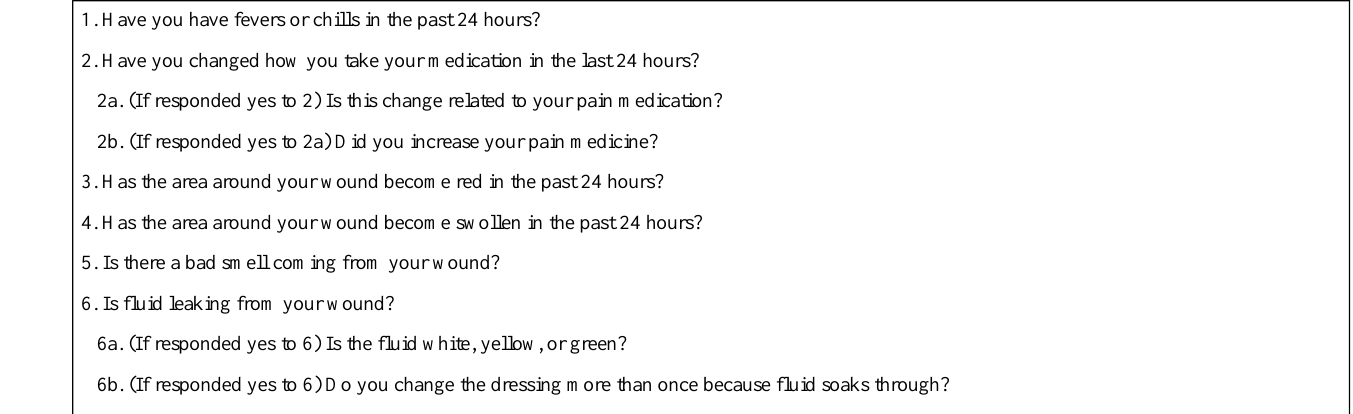
Figure 2. Wound Check app data flow